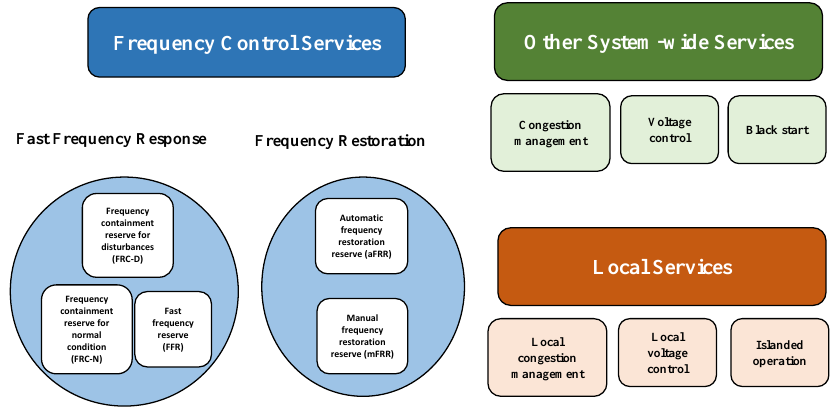
Figure 11. Flexibility services that can be provided by an energy community.